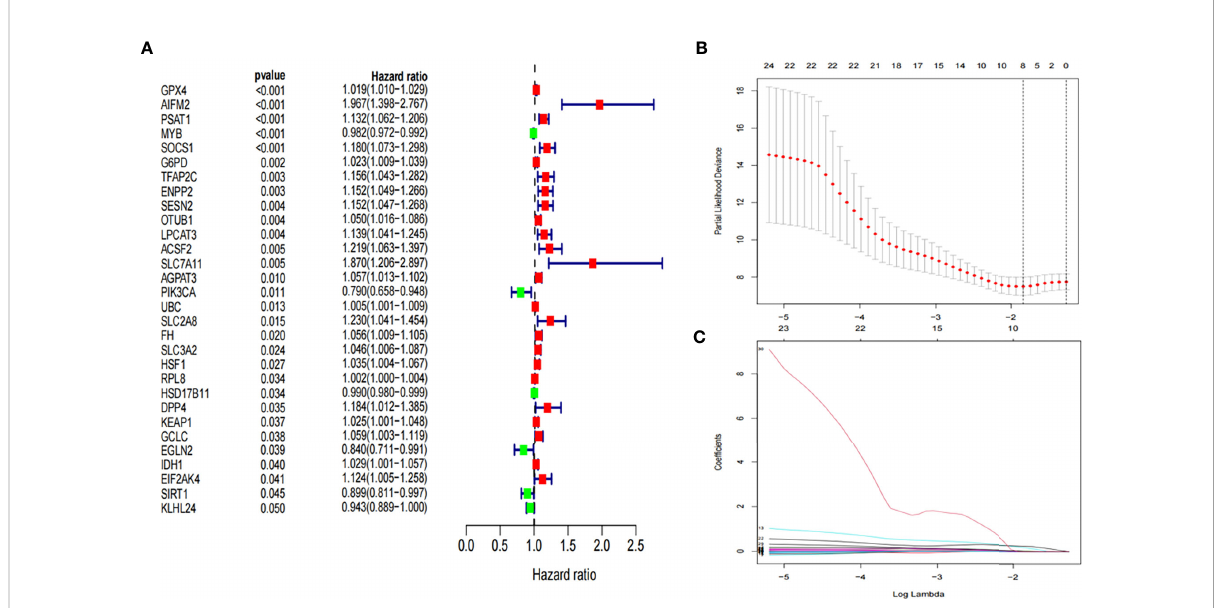
FIGURE 2 Development of prognostic ferroptosis-related genes. (A) Forest plot of univariate Cox regression identi fi ed 30 ferroptosis-related genes associated with overall survival. (B, C) LASSO Cox regression was performed to identify ferroptosis-related genes closely associated with prognosis of AML. LASSO, Least Absolute Shrinkage and Selection Operator; AML, Acute myeloid leukemia;.